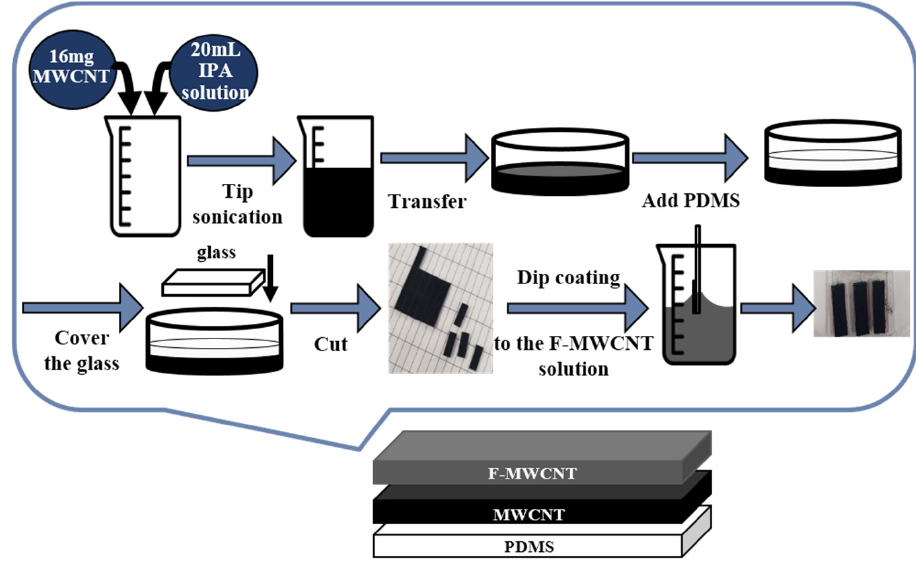
Figure 2. Fabrication process for the F-MWCNT/MWCNT/PDMS composite electrode.